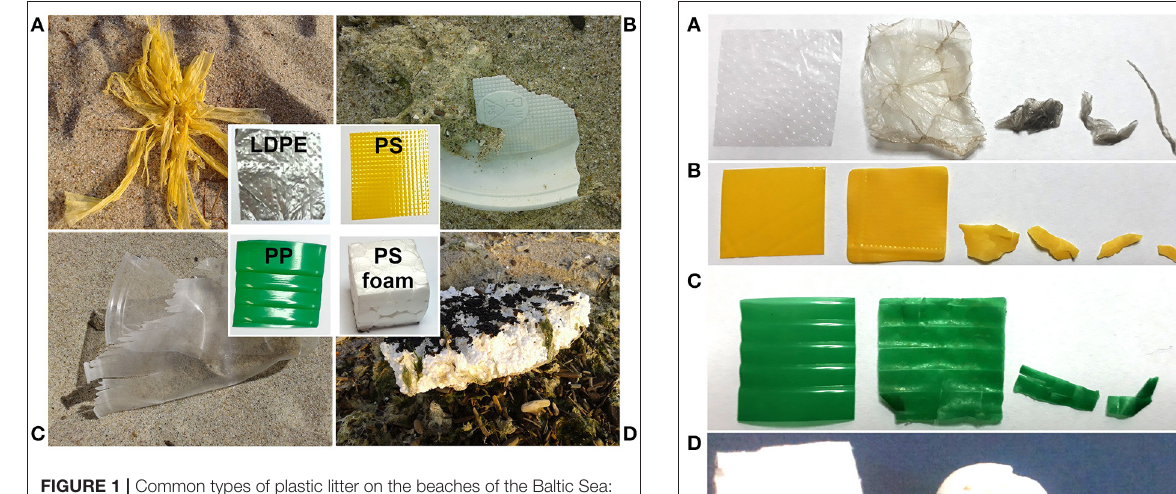
FIGURE 1 | Common types of plastic litter on the beaches of the Baltic Sea: (A) polyethylene (LDPE) garbage bags, (B) polystyrene (PS) single-use plates, (C) polypropylene (PP) single-use beverage glasses, and (D) building insulations sheets (foamed PS) (D) . Photos by I. Chubarenko. In the center–respective laboratory samples prepared for the experiment.